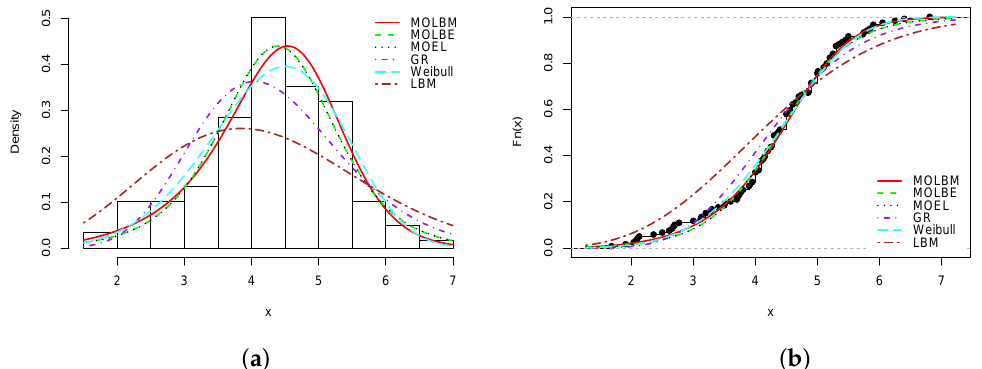
Figure 4. Plots of ( a ) estimated pdf and ( b ) estimated cdf of the MOLBM model with those of the other competitive models for Data set 2.